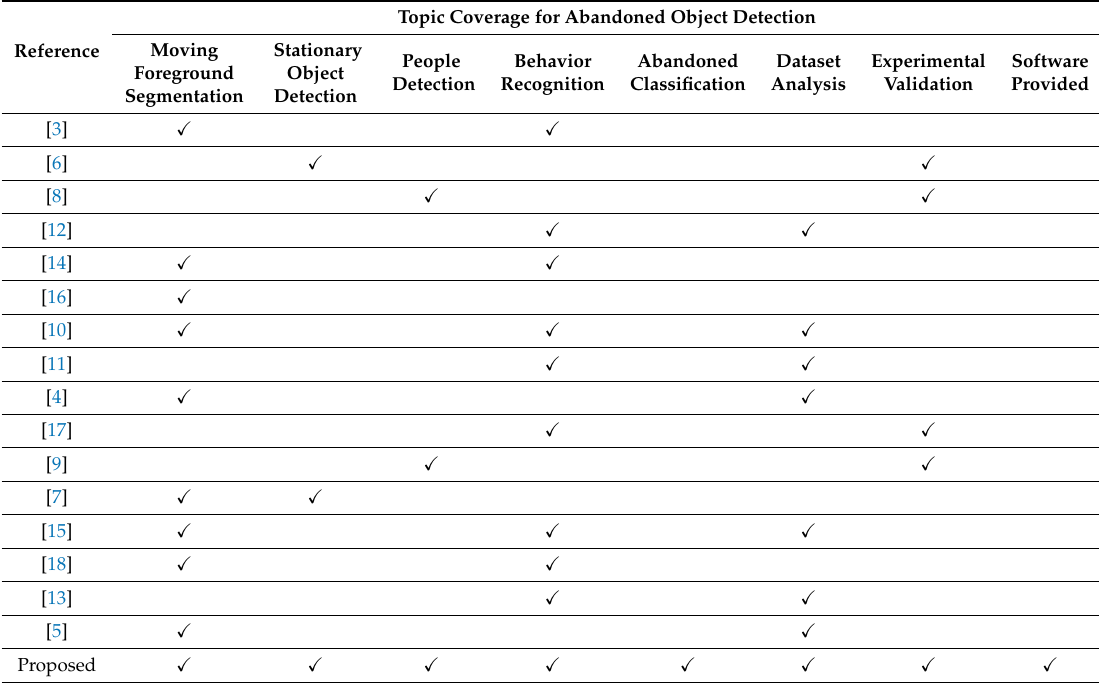
Table 1. Comparison with related surveys for the video-surveillance